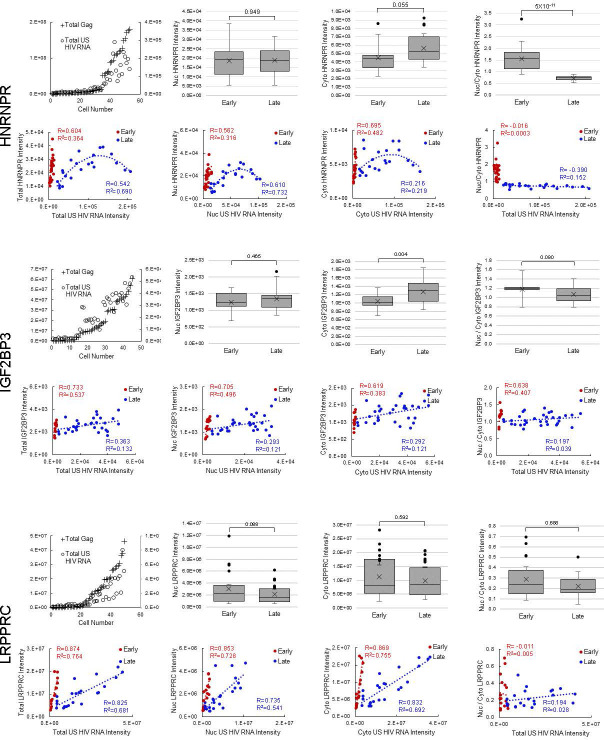
Host protein expression and cellular distribution.